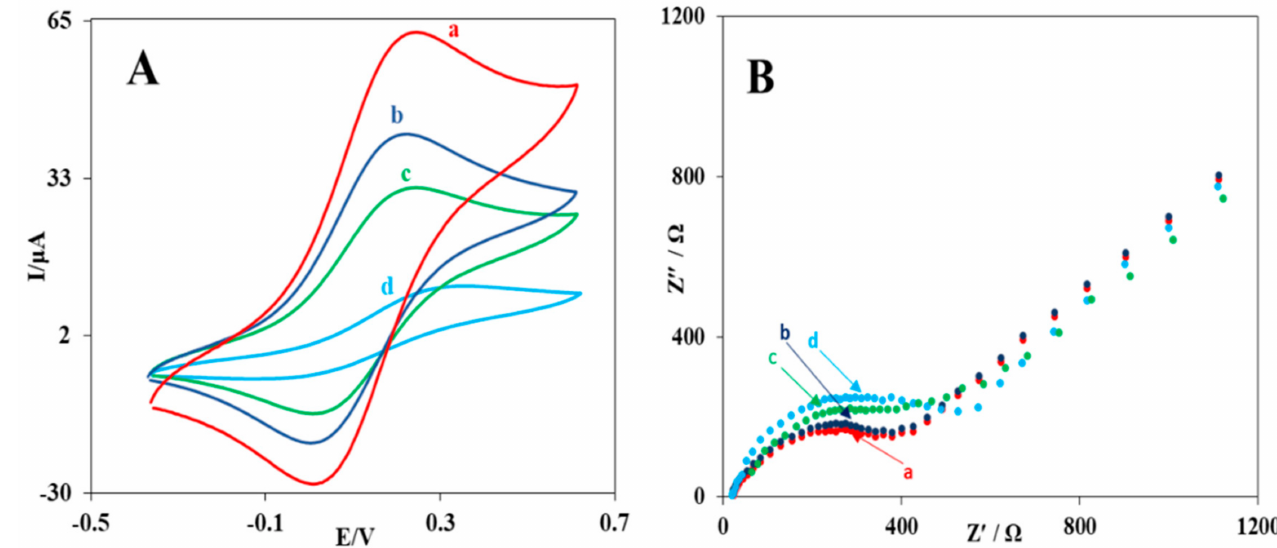
Figure 2. Cyclic voltammograms ( A ) and Nyquist curves ( B ) for unmodified glassy carbon electrodes (a) modified with solution containing MWCNTs-AuNPs (b) MWCNTs-AuNPs/CS-AuNPs (c) and MWCNTs-AuNPs/CS-AuNPs/rGO-AuNPs (d), at a scan rate of 100 mV/s. KCl 0.1 M and K 3 Fe (CN) 6 and K 4 Fe (CN) 6 3.0